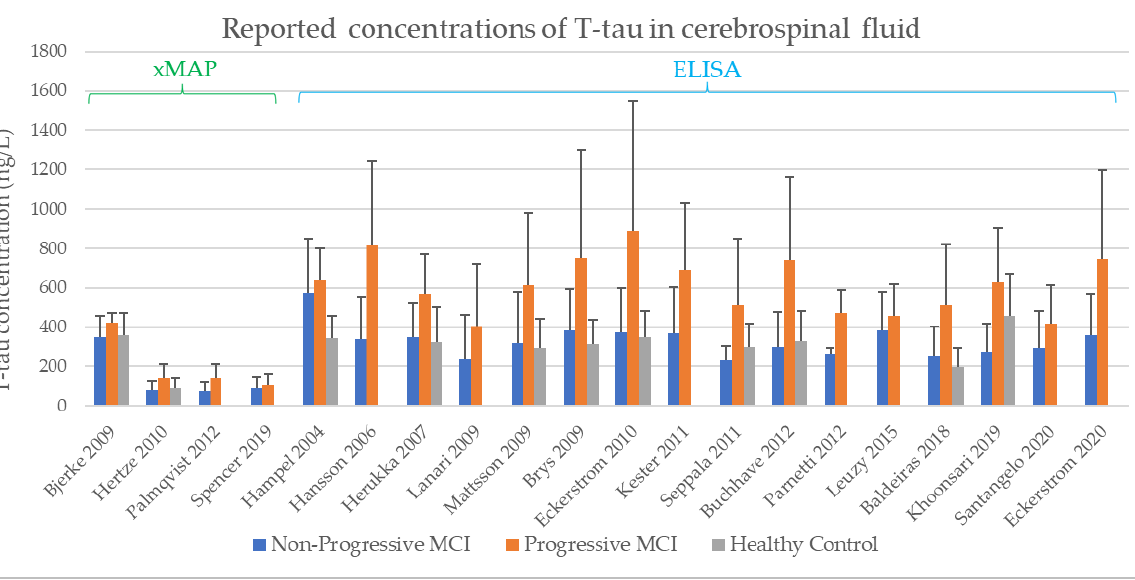
Figure 4. Concentration of T-tau in CSF, as determined by xMAP and ELISA.